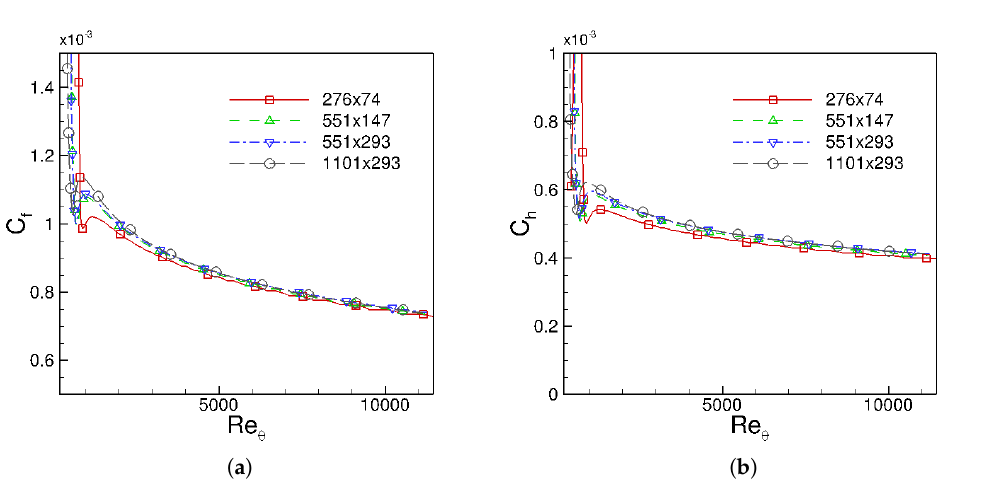
Figure 3. ( a ) Wall skin friction and ( b ) wall heat flux coefficients grid convergence study using the k - ω SST on four successive grid